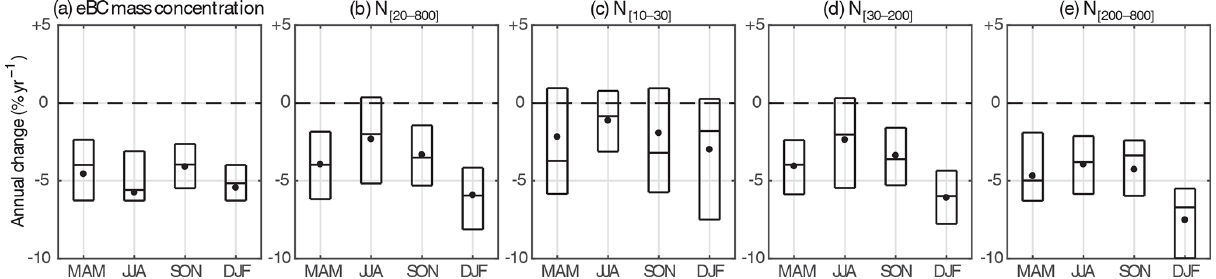
Figure 5. Seasonal statistics of the trends of PNCs and eBC mass concentration. Dots denote the mean slope for all sites, the black line inside the box denotes the median slope, and the top and bottom of the box denote the 75th and 25th percentiles. Spring: March to May (MAM); summer: June to August (JJA); autumn: September to November (SON); and winter: December to February